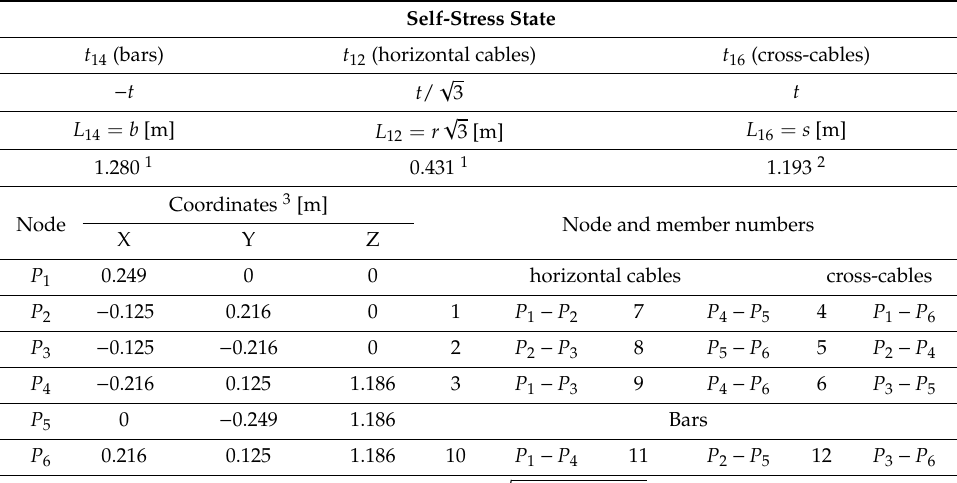
Table 1. Data on the tested simplex module ( ϕ = 5 π